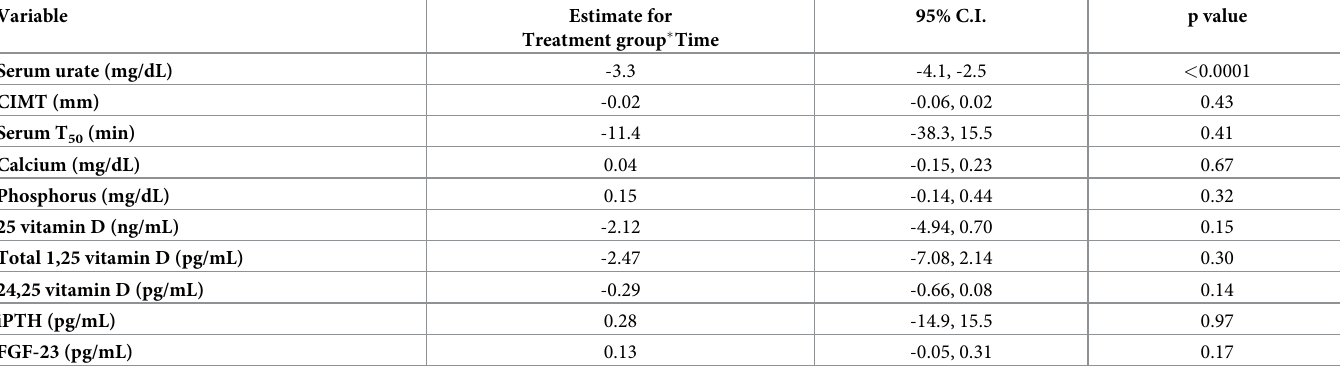
Table 2. Effect of treatment group compared to placebo over the 12-weeks study